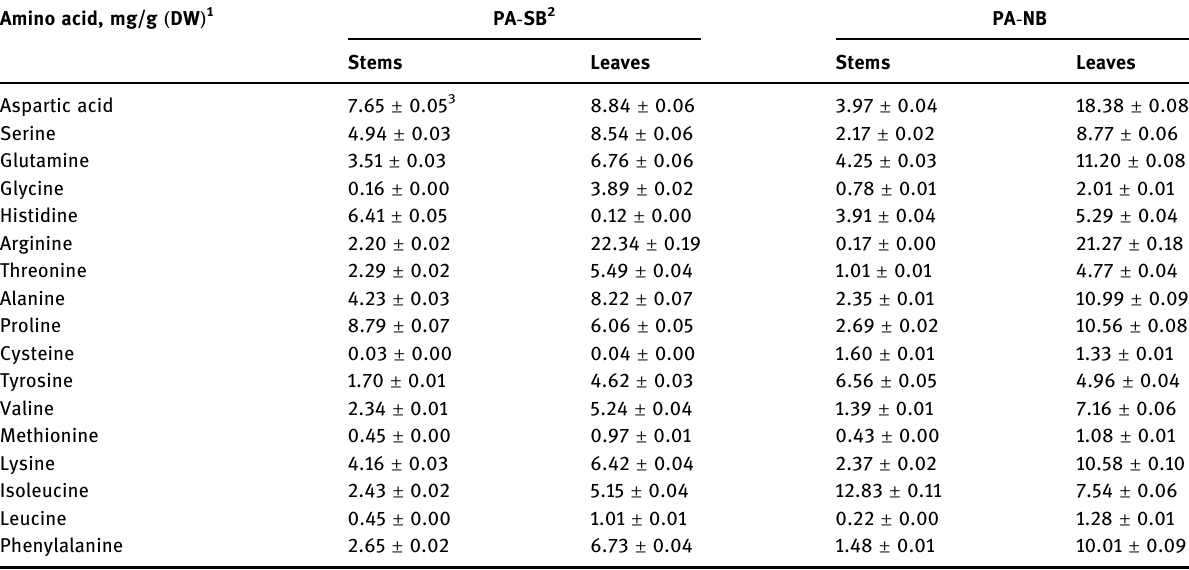
Table 2: Amino acid composition of P. alkekengi leaves and stems Amino acid, mg/g ( DW )